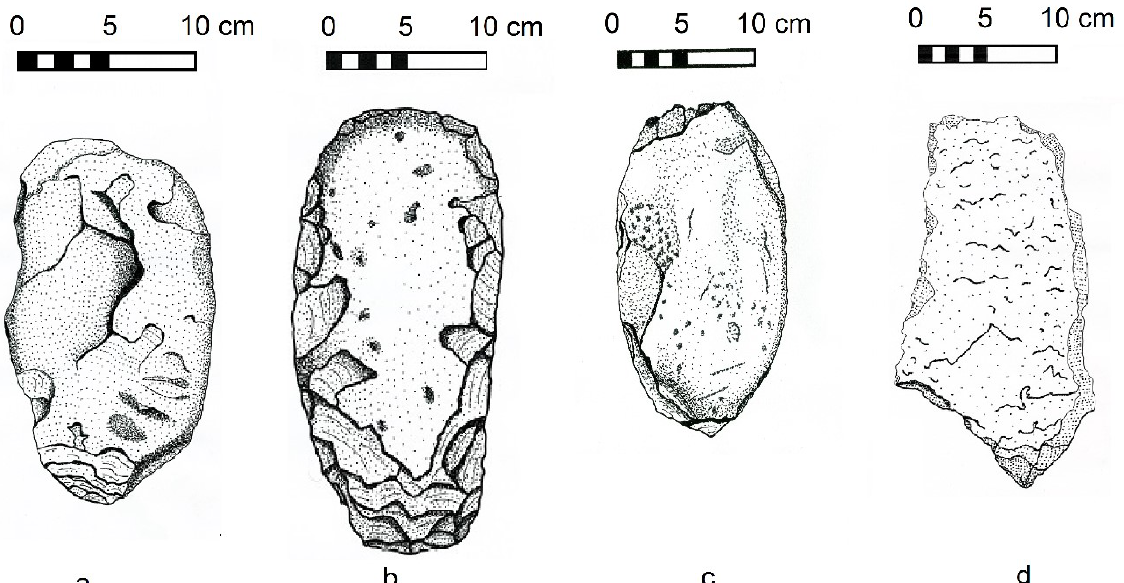
Figure 8. Examples of sub-rectangular-shaped digging tools. (a) Specimen 1, tool with one retouched working edge and retouched backing; (b) Specimen 10, tool with one working edge and two other edges extensively shaped by retouch; (c) Specimen 5, tool with two opposing retouched working edges; and (d) Specimen 8, tabular tool with a work-related step-fractured distal end. (Drawings by Steve